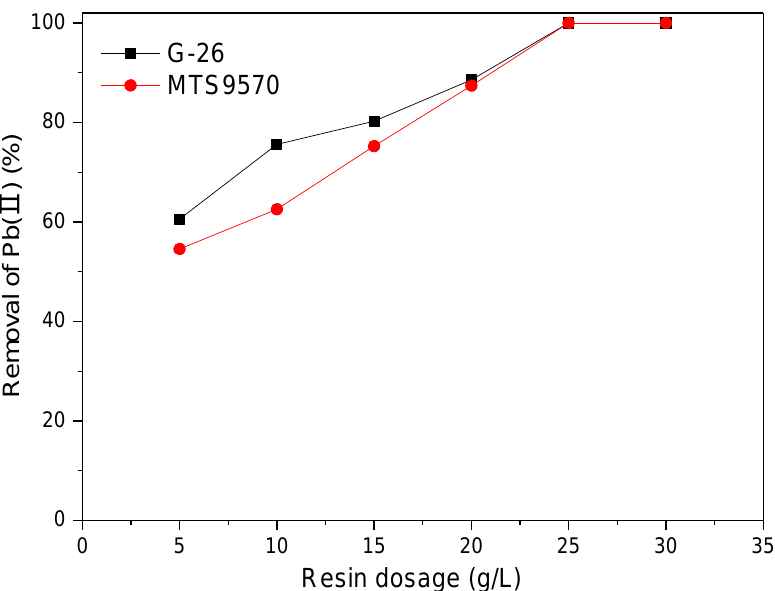
Figure 4. Effect of resin dosage on adsorption of Pb(II) using G-26 and MTS9570 exchange resins at 20 min agitation time, 150 rpm agitation speed, pH 3.5, concentration 1000 mg/L, and temperature 20 °C.